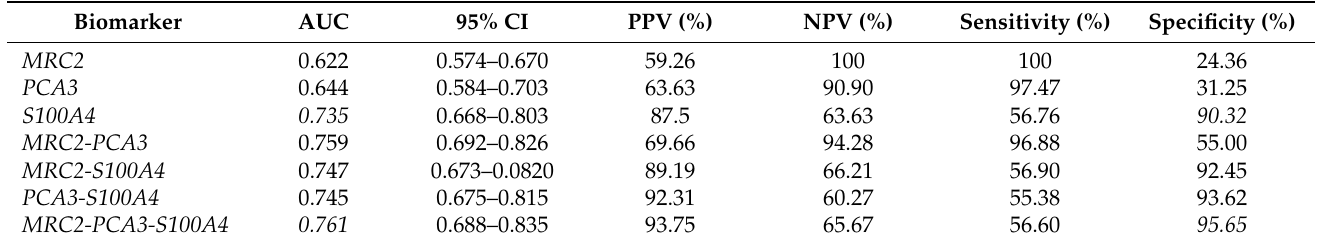
Table 2. ROC parameters for diagnosis of PC patients in serum biomarkers alone and combined.